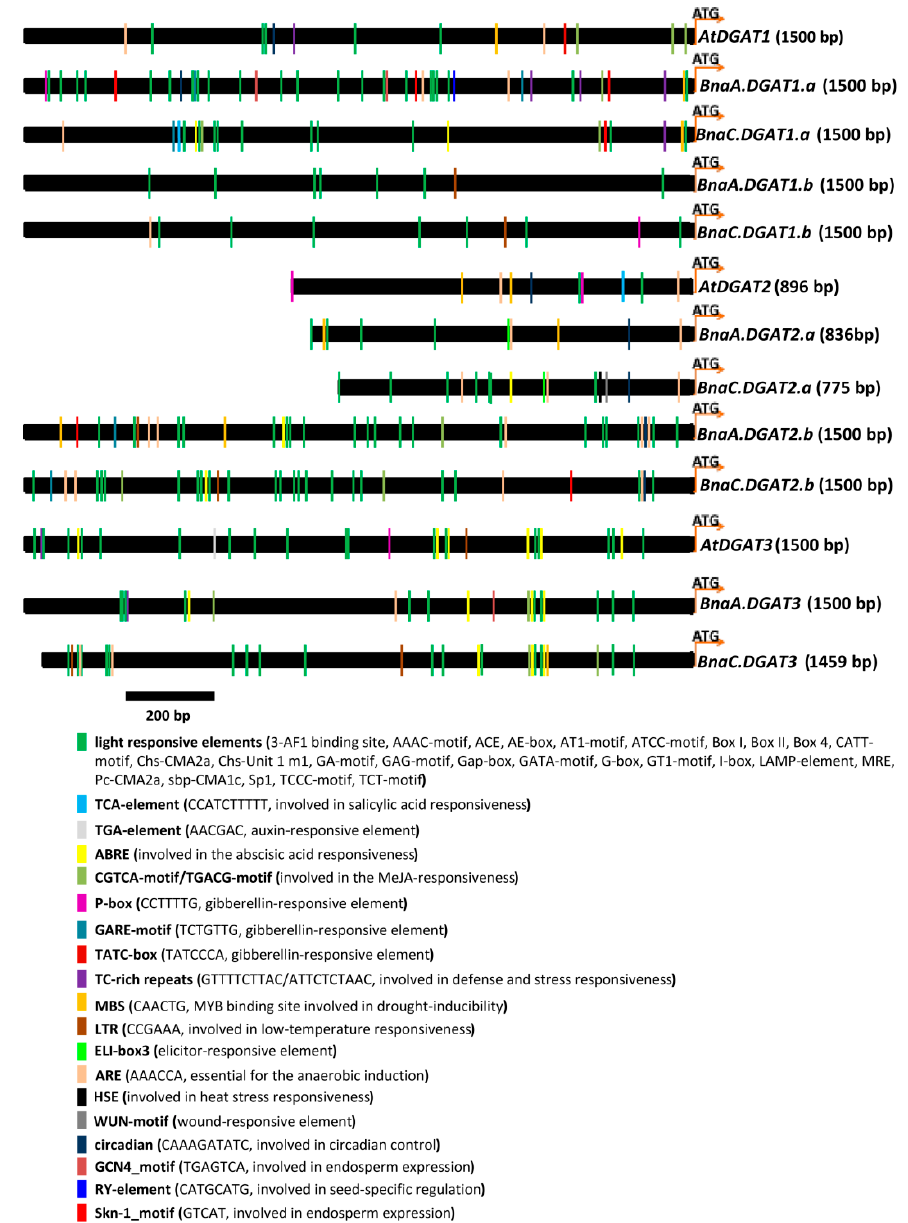
Figure 9. Potential cis -acting regulatory elements upstream of the start codons of BnaDGATs and AtDGATs deduced by PlantCARE. P BnaA.DGAT1.a , P BnaC.DGAT1.a , P BnaA.DGAT1.b , P BnaA.DGAT2.a , P BnaC.DGAT2.a , P BnaA.DGAT2.b , P BnaC.DGAT2.b , P BnaA.DGAT3 and P BnaC.DGAT3 were cloned from B. napus ZS11. P AtDGAT1 , P AtDGAT2 and P AtDGAT3 were derived from the Arabidopsis database (https://www.arabidopsis.org (accessed on 25 March 2020)). P BnaC.DGAT1.b was extracted from the ZS11 genome database (https://www.ncbi.nlm.nih.gov/assembly/GCF_000686985.2/ (accessed on 20 September 2021)). Black bar = 200 bp.